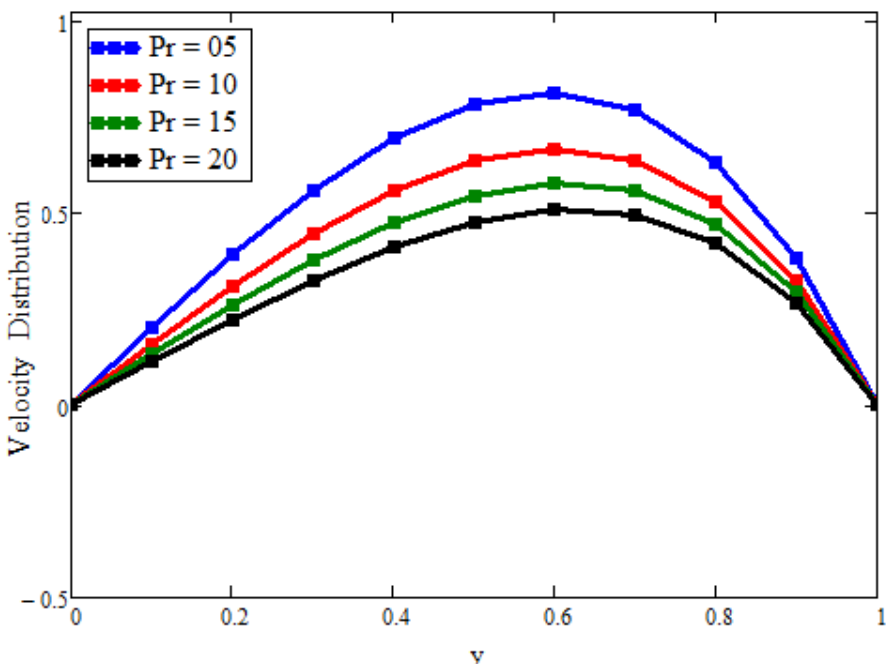
(cid:3035)(cid:3041)(cid:3033) = 0.02, 𝛼 = 𝛽 = 𝛾 = 0.5 .